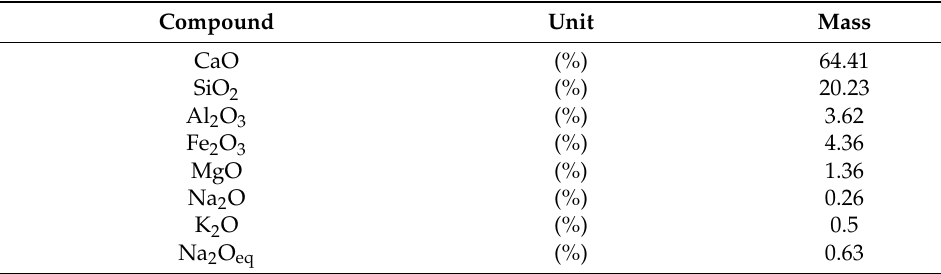
Table 2. The chemical composition of CEM I 42.5 R [40].